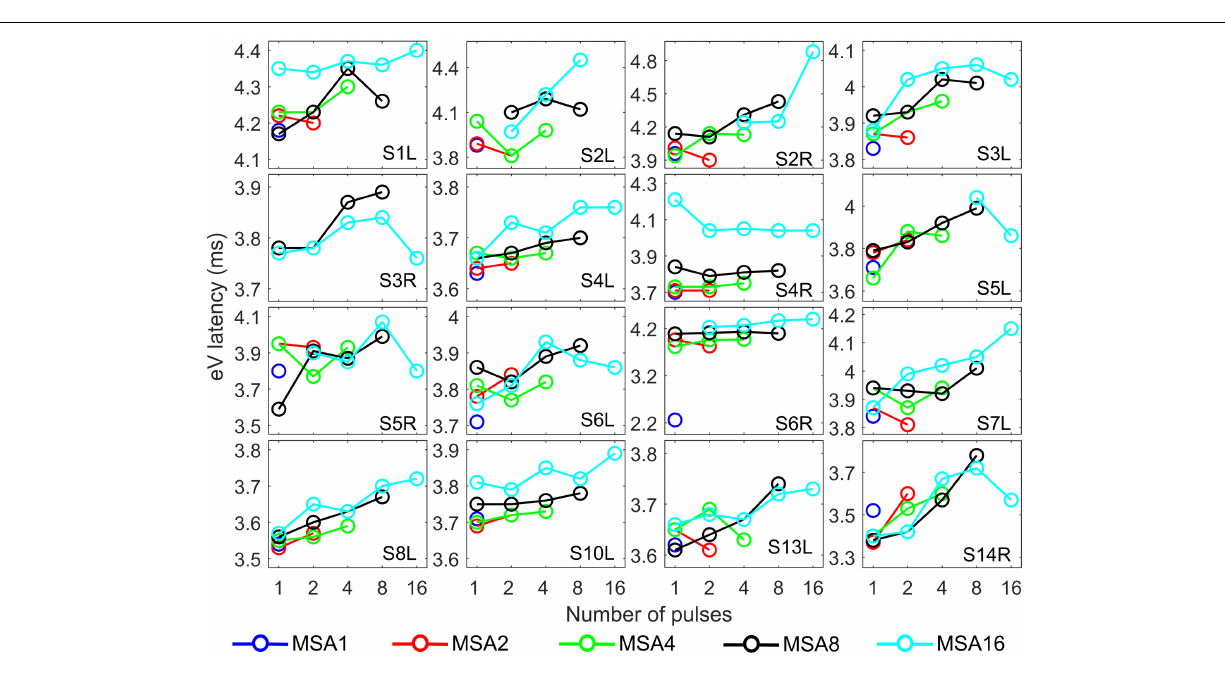
FIGURE 8 | eABR wave eV latencies corresponding to the 15 measurement conditions mentioned in Figure 2 . Curves with specific colors represent responses to stimuli with fixed stimulation amplitude and varying numbers of